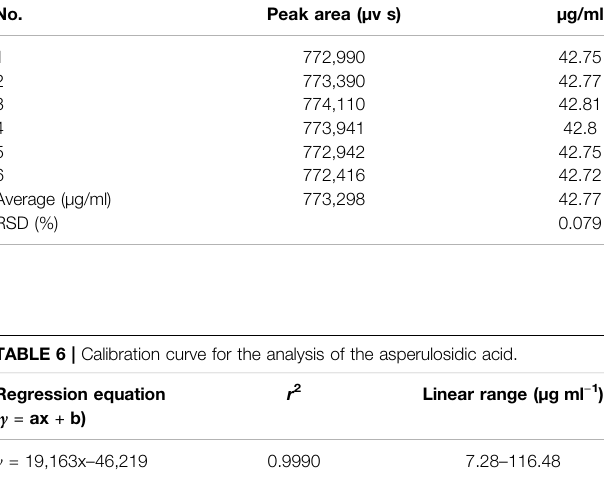
TABLE 5 | Precision for the analysis of the asperulosidic acid ( n (cid:2) 6). No.